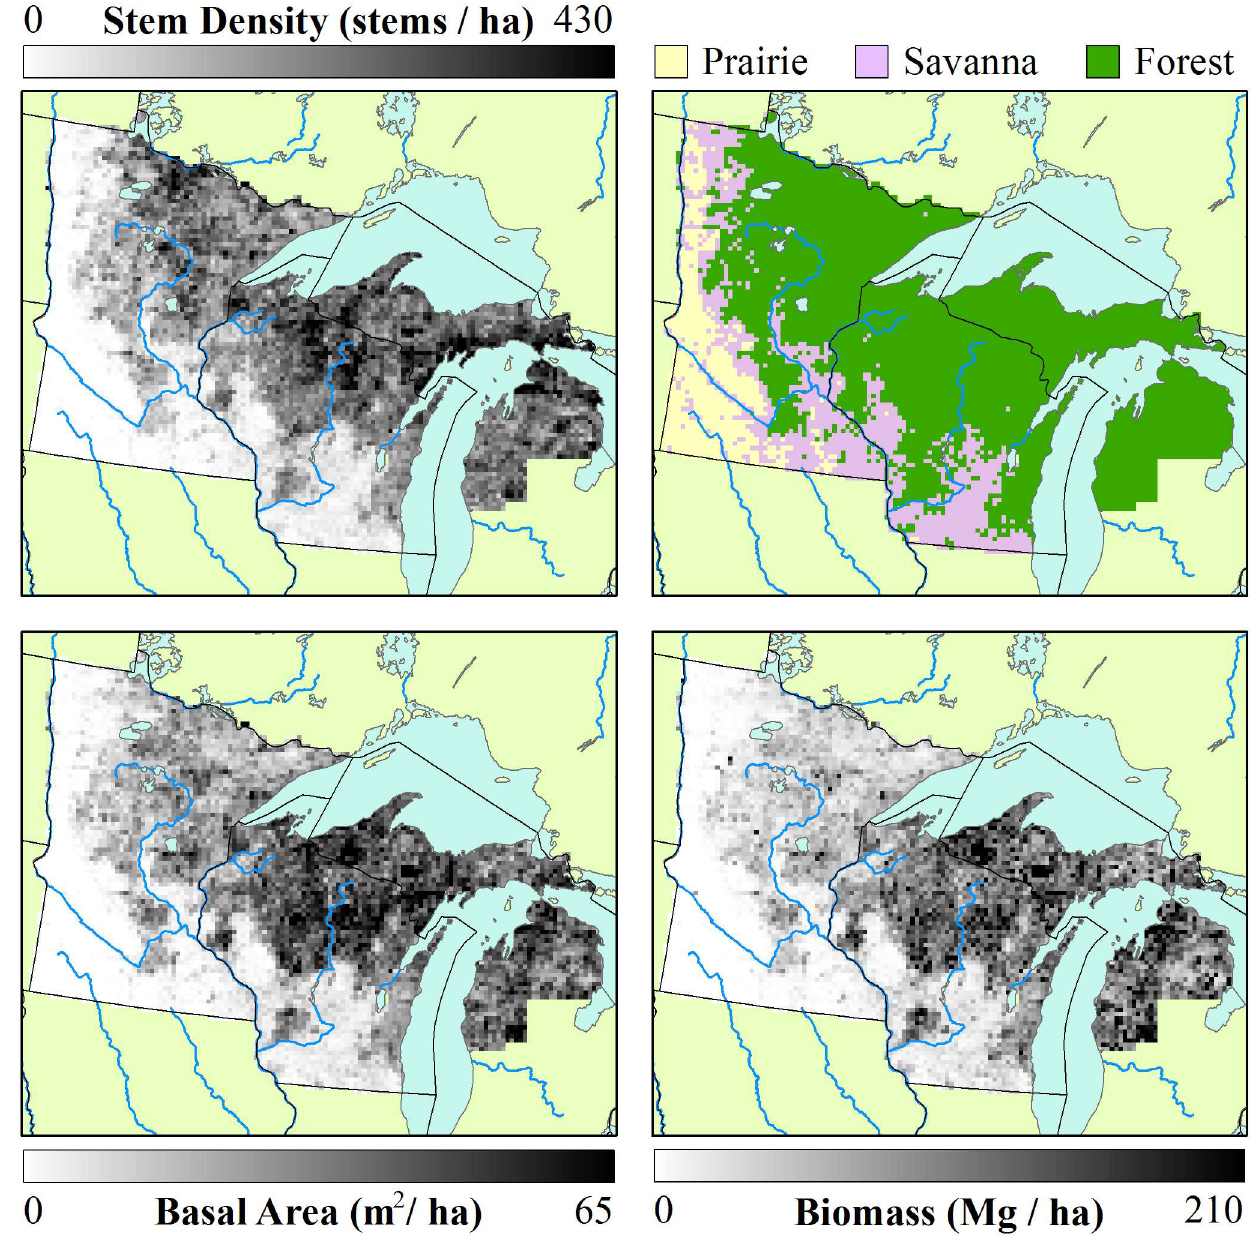
Fig 2. Structural characteristics of PLS era forests. Total stem density (a) in the Upper Midwest, along with forest type classification(b) basedon PLSS data and the stem density thresholds definedby Andersonand Anderson[44] (Prairie: < 0.5 stems ha -1 ; Savanna: 0.5–47 stems ha -1 ; Forested: > 47 stems ha -1 ). Fine lines represent major rivers. To a first order, basal area (c) and biomass (d) show similar patterns to stem density (but see Fig 3).